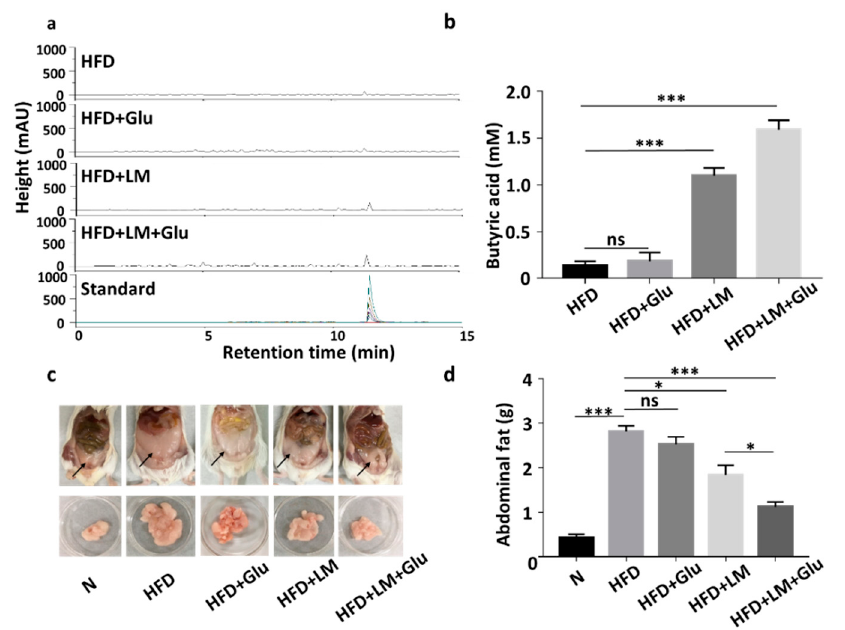
Figure 2. Butyric acid production of L. mesenteroides EH-1 in cecum and inhibition of abdominal fat depots in high-fat diet (HFD)-fed mice. ( a ) HFD-fed Institute of Cancer Research (ICR) mice were administered with L. mesenteroides EH-1 (LM) in the presence or absence of 2% glucose (Glu) via oral gavage every day for four days. The high-performance liquid chromatography (HPLC) chromatograms of butyric acid in mouse cecum were displayed. ( b ) The concentration (mM) of butyric acid was quantified based on the heights (milli-absorbance unit (mAU)) of standard peaks with concentrations of butyric acid from 0–20 mM. The level (1.591 ± 0.101, n = 5) of butyric acid in mouse cecum after LM administration was significantly increased compared to that (0.136 ± 0.044, n = 5) in HFD-fed mice. ( c,d ) Abdominal fat depots (arrows) in HFD-fed mice administered with L. mesenteroides EH-1 in the presence (1.118 ± 0.111, n = 5) or absence (1.838 ± 0.217, n = 5) 2% glucose for 25 days were dissected and weighted. Abdominal fat depots in mice fed with normal diet (N) (0.426 ± 0.072, n = 5) were included for comparison. Data are represented as mean ± SD of experiments performed in triplicate and five replicates. * p < 0.05; *** p < 0.001; ns = nonsignificant. Bars = 10 mm.